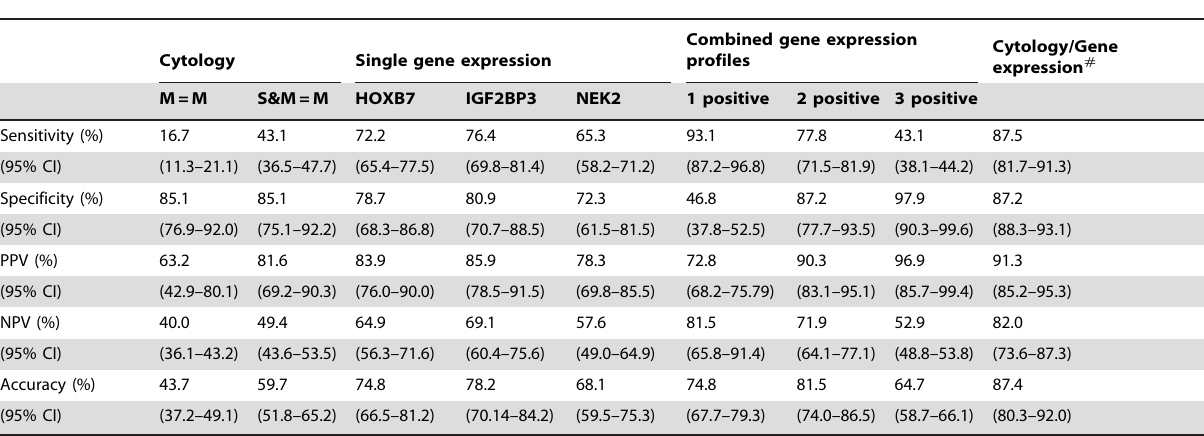
Table 4. Performance Characteristics for Entire Group (CCC and Pancreatic Cancer) (n